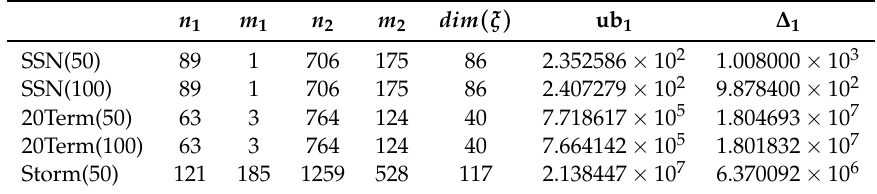
Table 1. Data about